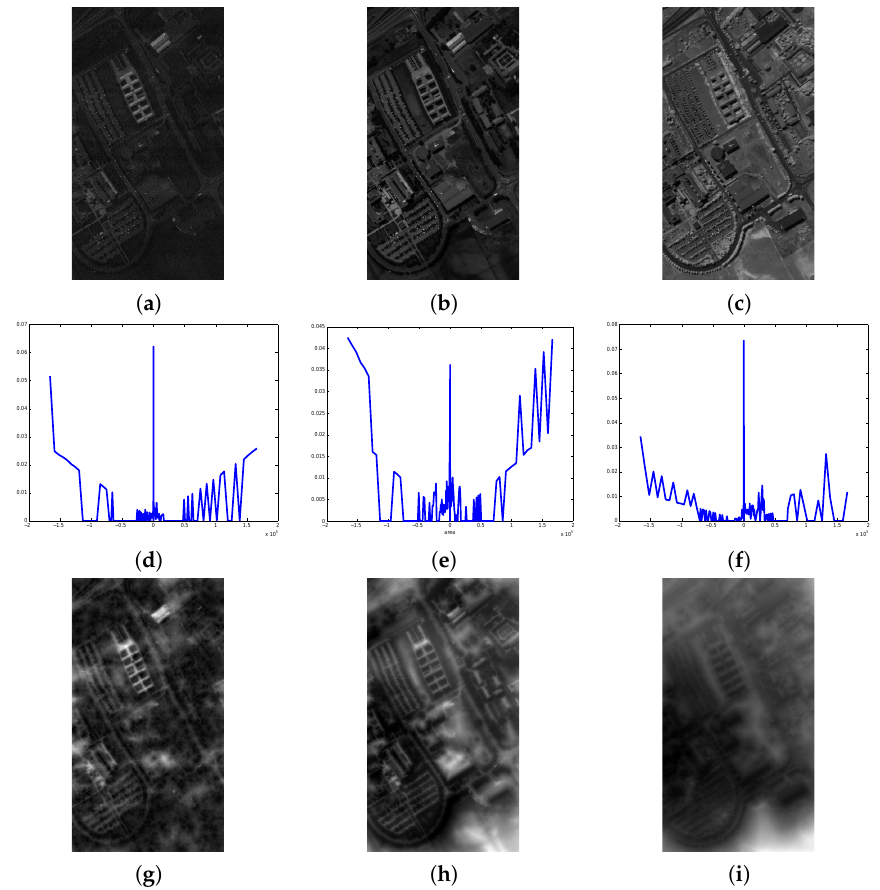
Figure 8. Top, three examples of spectral bands of Pavia image: ( a ) ♯ 1; ( b ) ♯ 50; ( c ) ♯ 100; middle; ( d – f ) pattern spectrum (PS) of corresponding spectral bands; ( g – i ) Molchanov distance functions of corresponding spectral